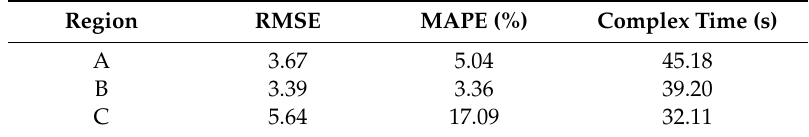
Table 5. Error metrics of the hybrid forecasting model in A, B, and C regions of Jeju Island.